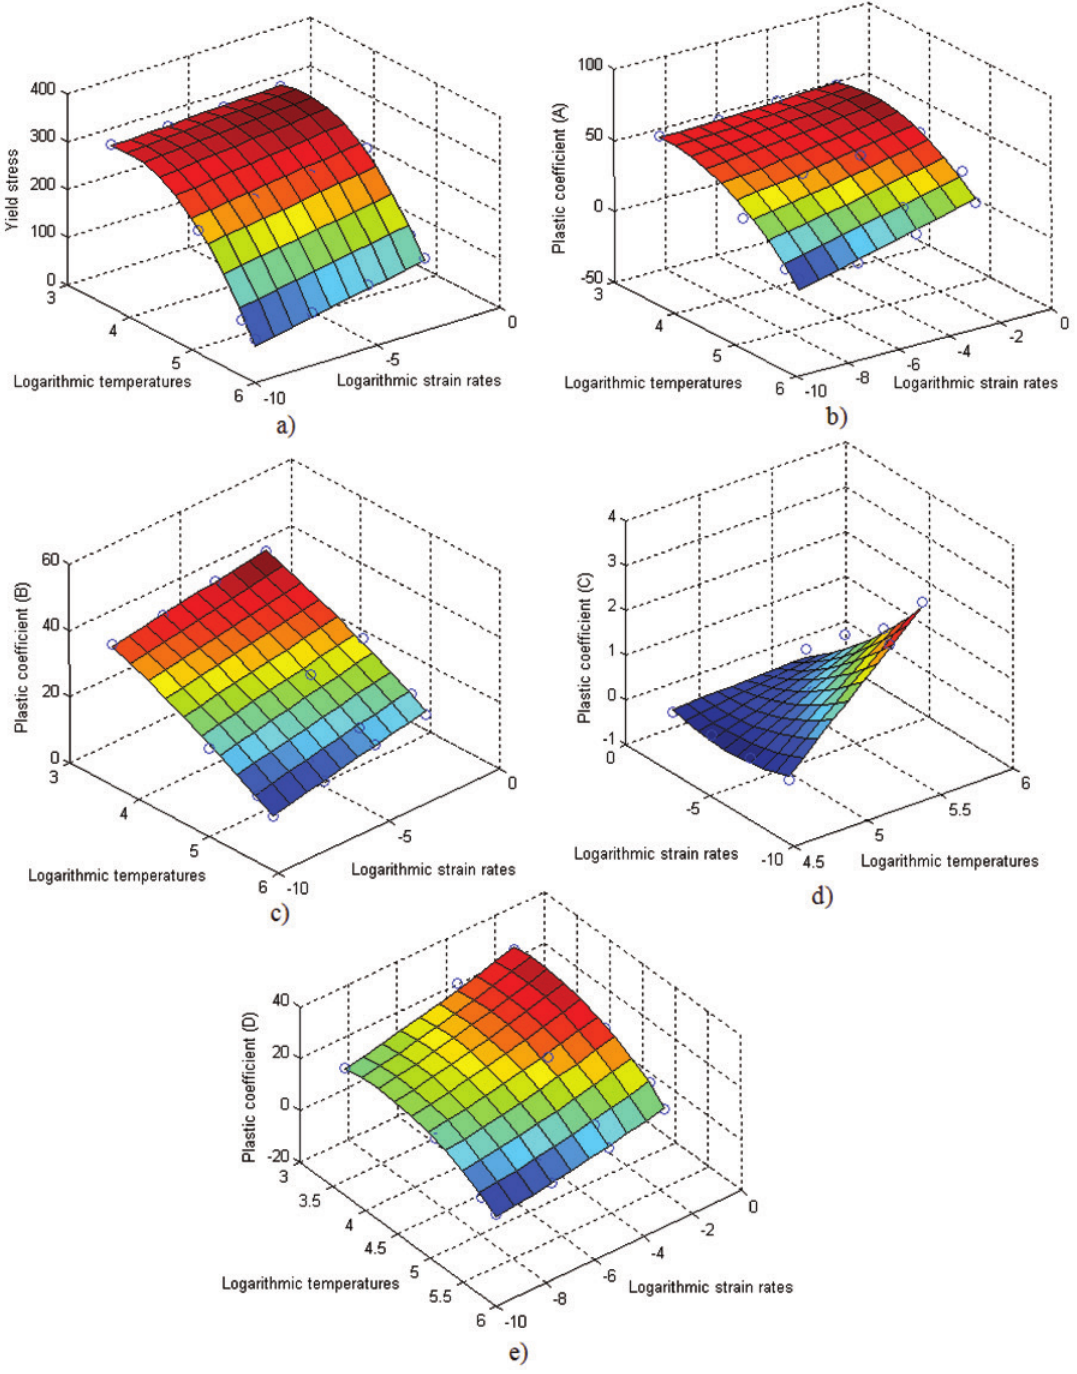
Fig. 4: Fitting surfaces based on the relationship of material parameters with temperatures and strain rates for (a) yield stress and (b)–(e) plastic coefficients A , B , C ,